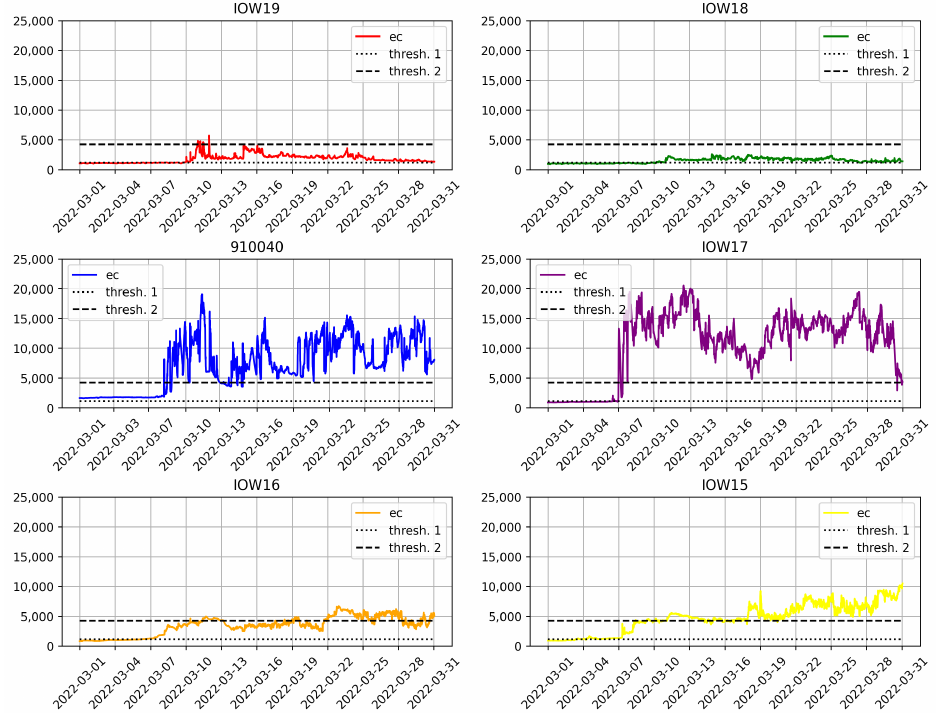
Figure 15. Variable ec plot during March with two thresholds: quantiles 25% (thresh 1) and 75% (thresh